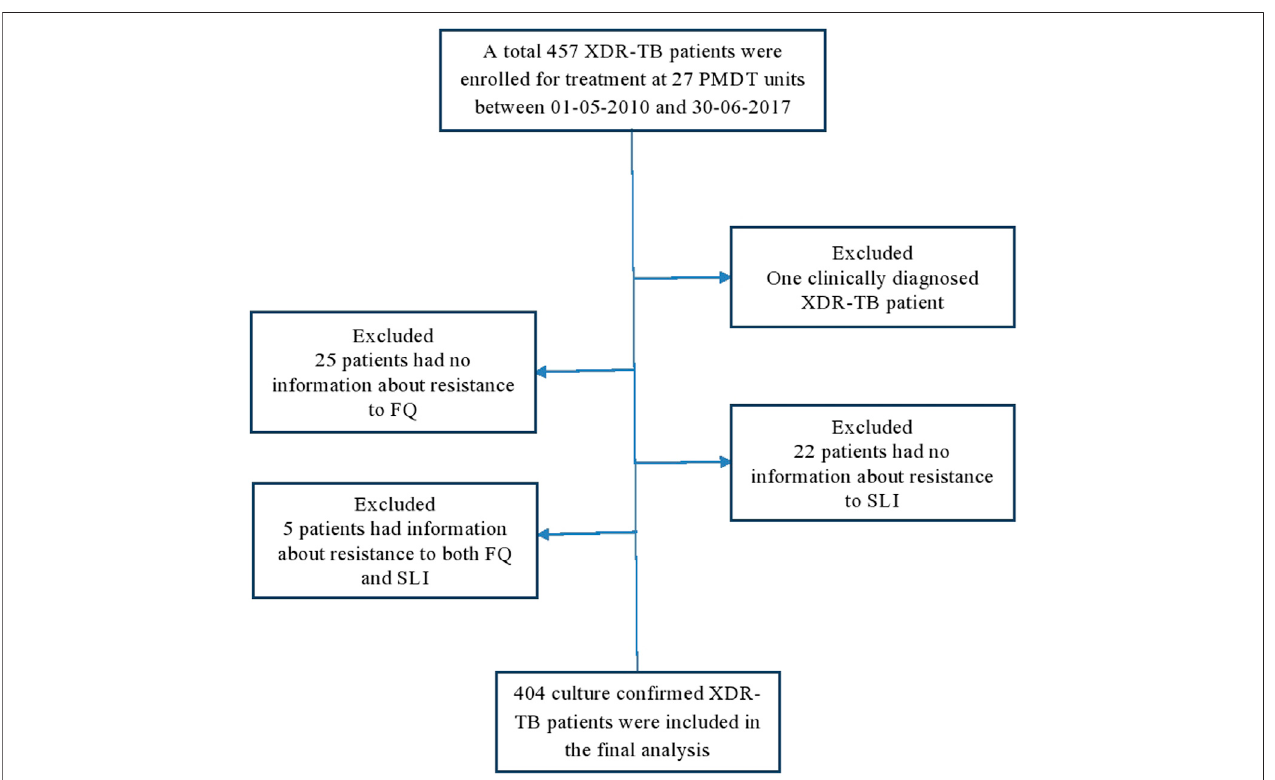
FIGURE 1 | Enrolment, inclusion and exclusion of study participants. DST, drug susceptibility testing; FQ fl uoroquinolones; SLI, second-line injectables; XDR-TB, extensively drug resistant tuberculosis